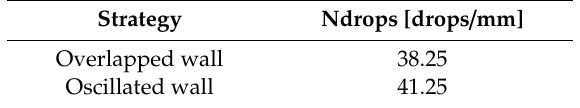
Table 4. Deposited number of drops per advanced millimeter in overlapping and oscillating strategies.